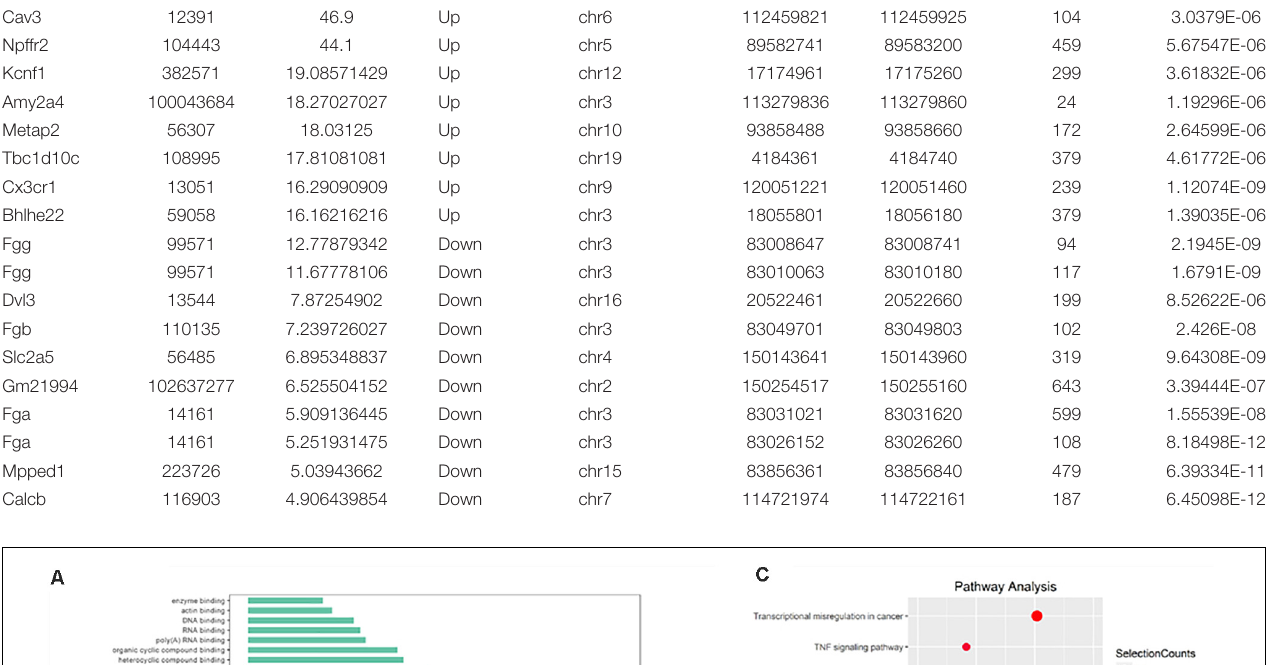
TABLE 2 | The top 20 differently methylated m6A peaks in TvI.